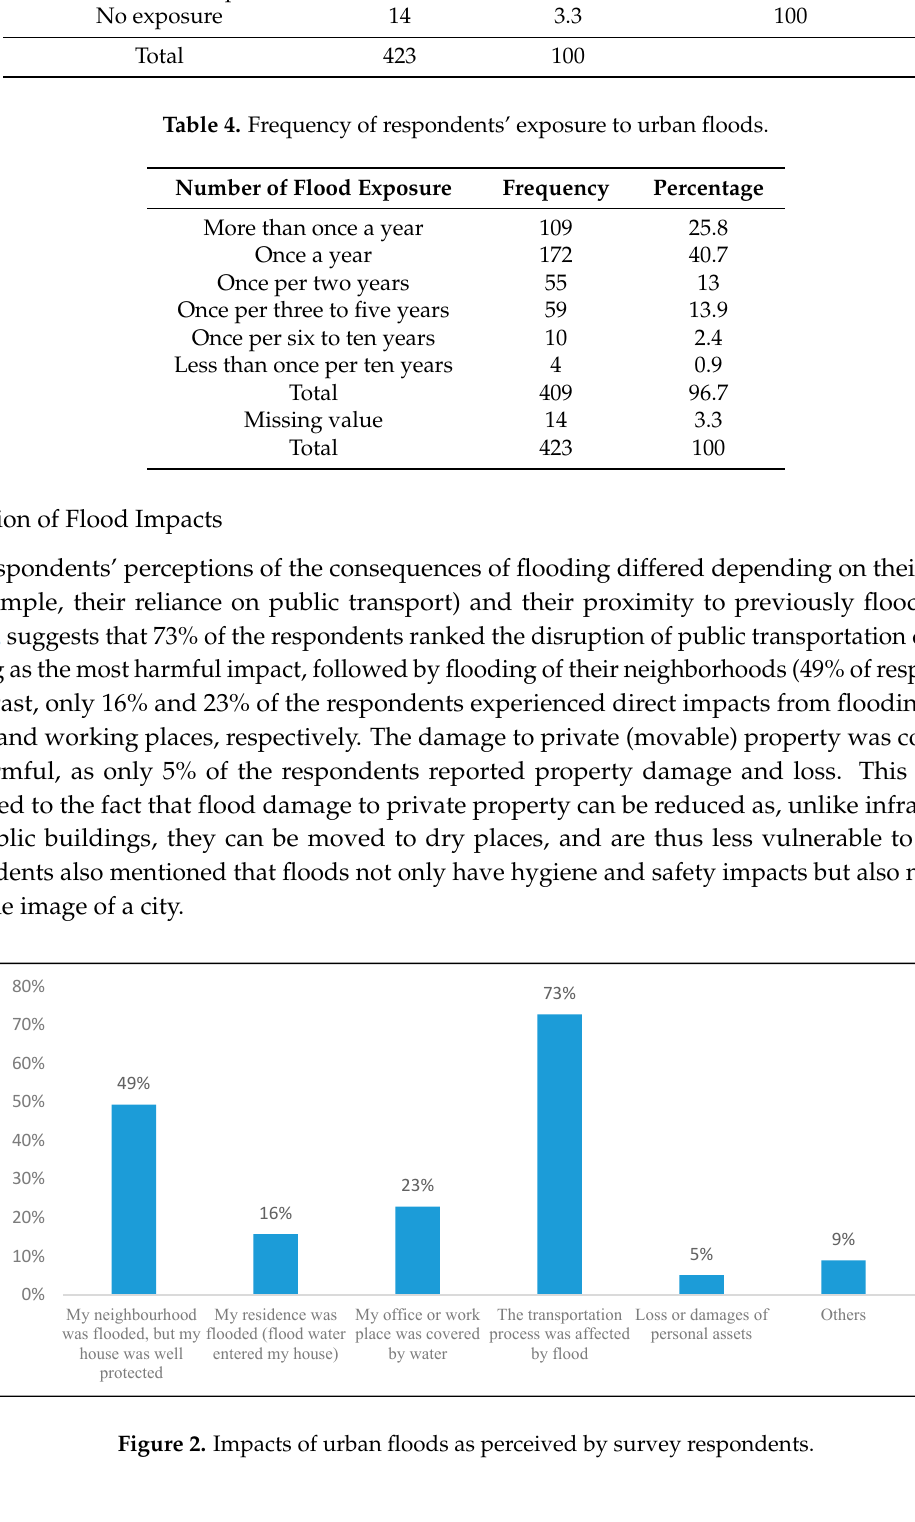
Table 4. Frequency of respondents’ exposure to urban floods.